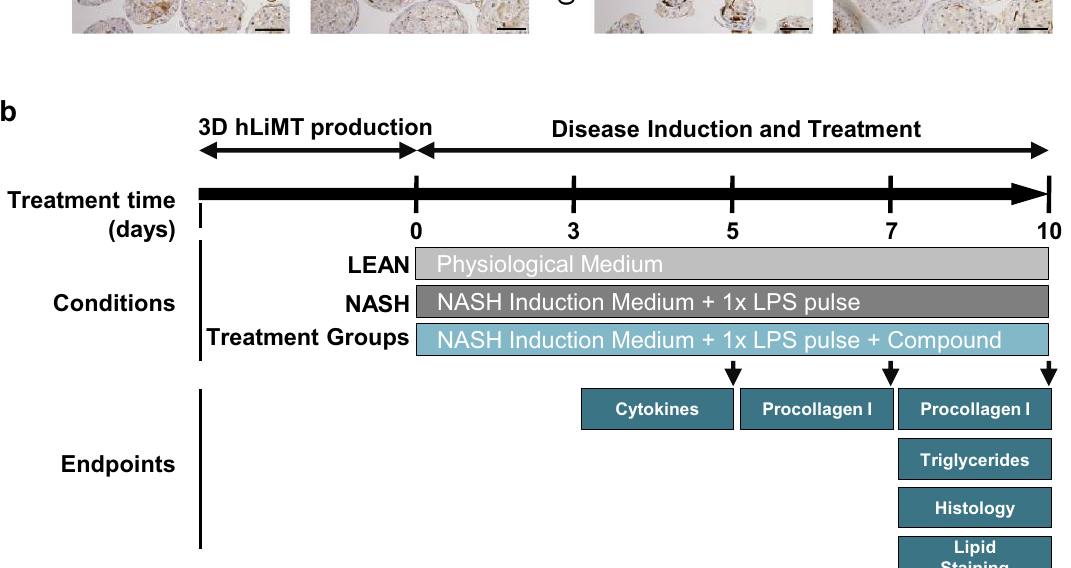
Figure 1. Method and characterization of hLiMTs for modeling NASH ( a ) H&E and IHC staining of liver specific makers representing the relevant cell types in the liver model. Scale bars indicate 100 μm. ( b ) Scheme for NASH induction. Disease induction and treatment starts at day 0 after the production of the 3D InSight hLiMTs. The three treatment conditions are: LEAN, NASH and NASH in the presence of test compound. After each medium exchange on days 0, 3, 5 and 7, the compounds and DMSO were applied. FFA supplementation occurred on each treatment day, while stimulation with LPS took place only once during the 10-day treatment period. Cell culture supernatants and/or microtissues were collected on days 5, 7 and 10. All conditions were normalized to 0.2%